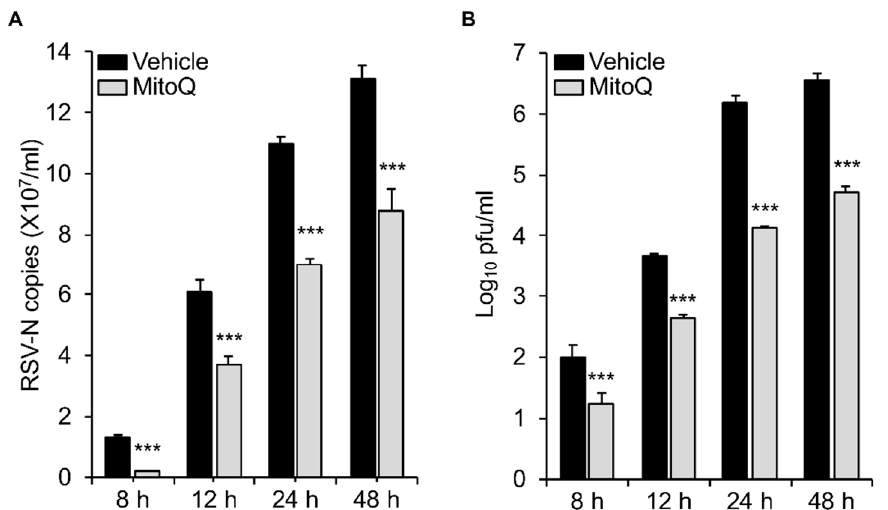
Figure 6. The mtROS scavenger mitoquinone mesylate (MitoQ) protects against RSV infection in A549 human adenocarcinomic alveolar basal epithelial cells. RSV-infected (MOI 1) A549 cells were treated with DMSO (vehicle) or MitoQ (1 µ M) for the last 8 h before virus harvest and cell lysate preparation. ( A ) qPCR and ( B ) plaque assays were performed to determine the viral RNA copy number and infectious virus (plaque forming units pfu / mL). Results shown represent the mean ± SEM ( n = 3 independent experiments, each performed in triplicate). *** p < 0.001 compared to the vehicle.